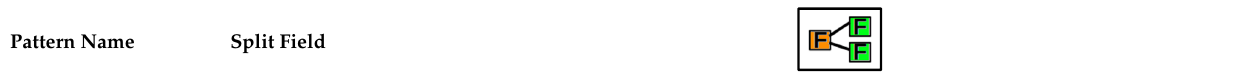
Figure 5. Integration pipeline with three EIPs (Splitter, Translator, and Aggregator).